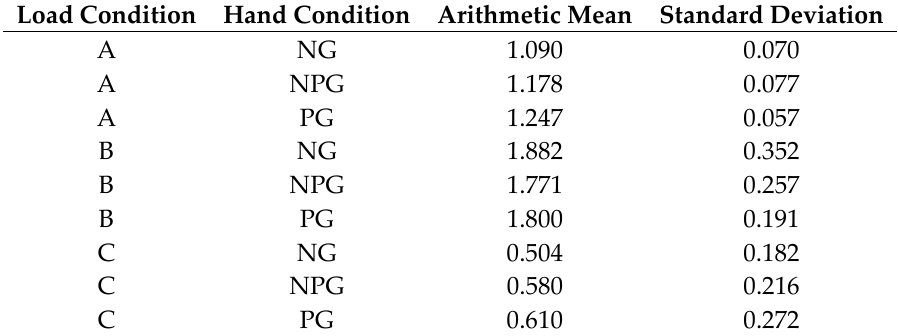
Table 2. Arithmetic means and standard deviations for transmissibility of all six